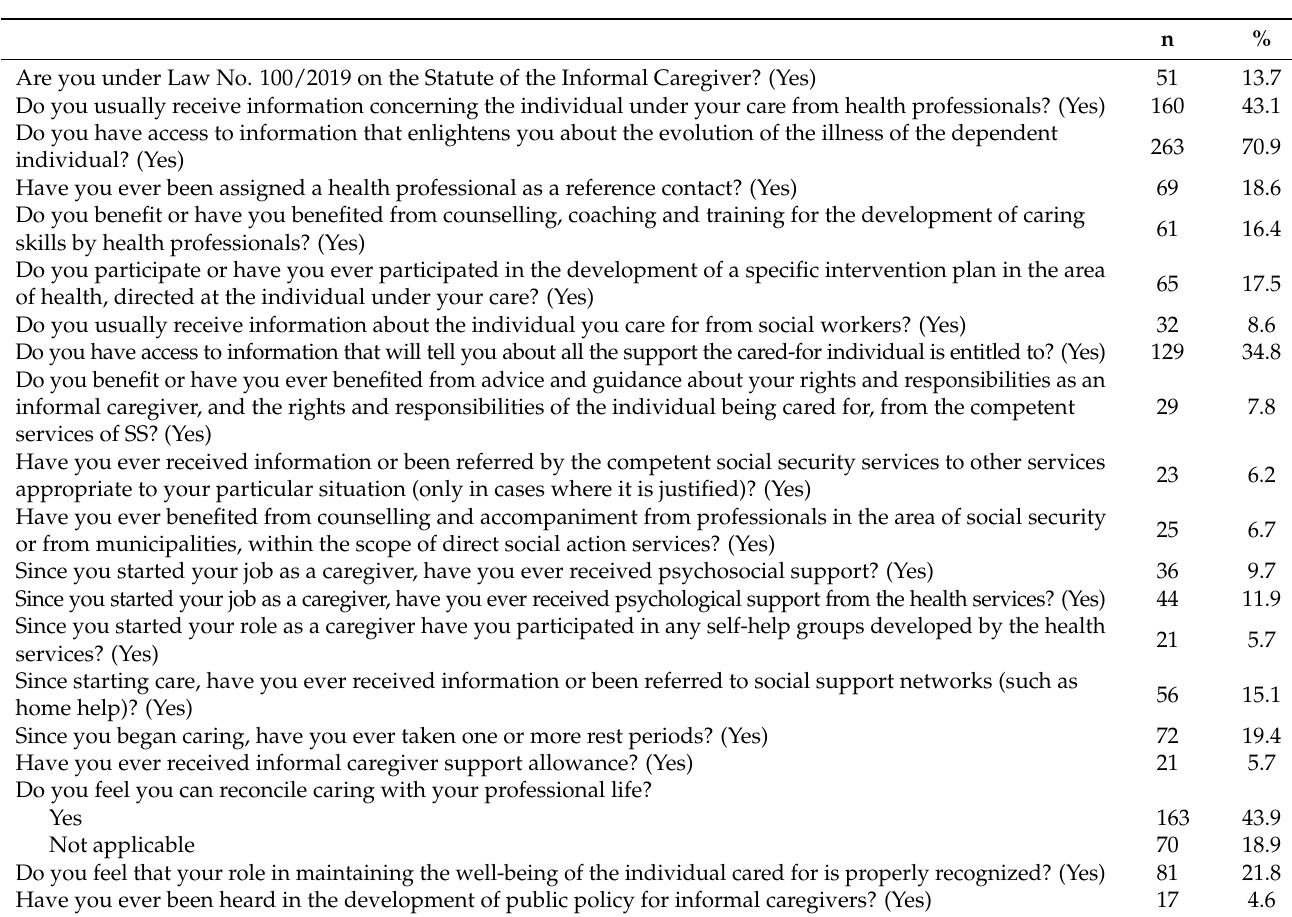
Table 13. Analysis of the frequency of answers to information on informal caregiver status.